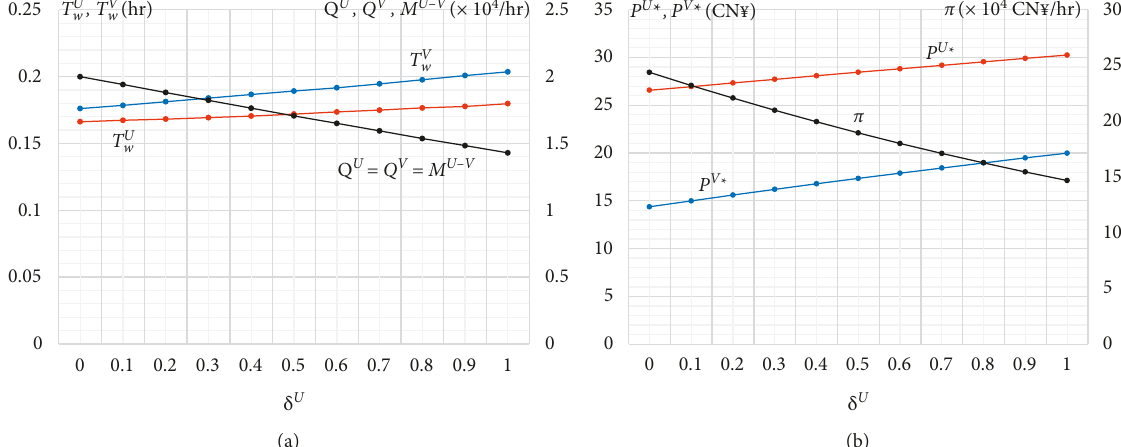
Figure 7: Sensitivity analysis with respect to drivers’ scaling factor. (a) Changes in T U π